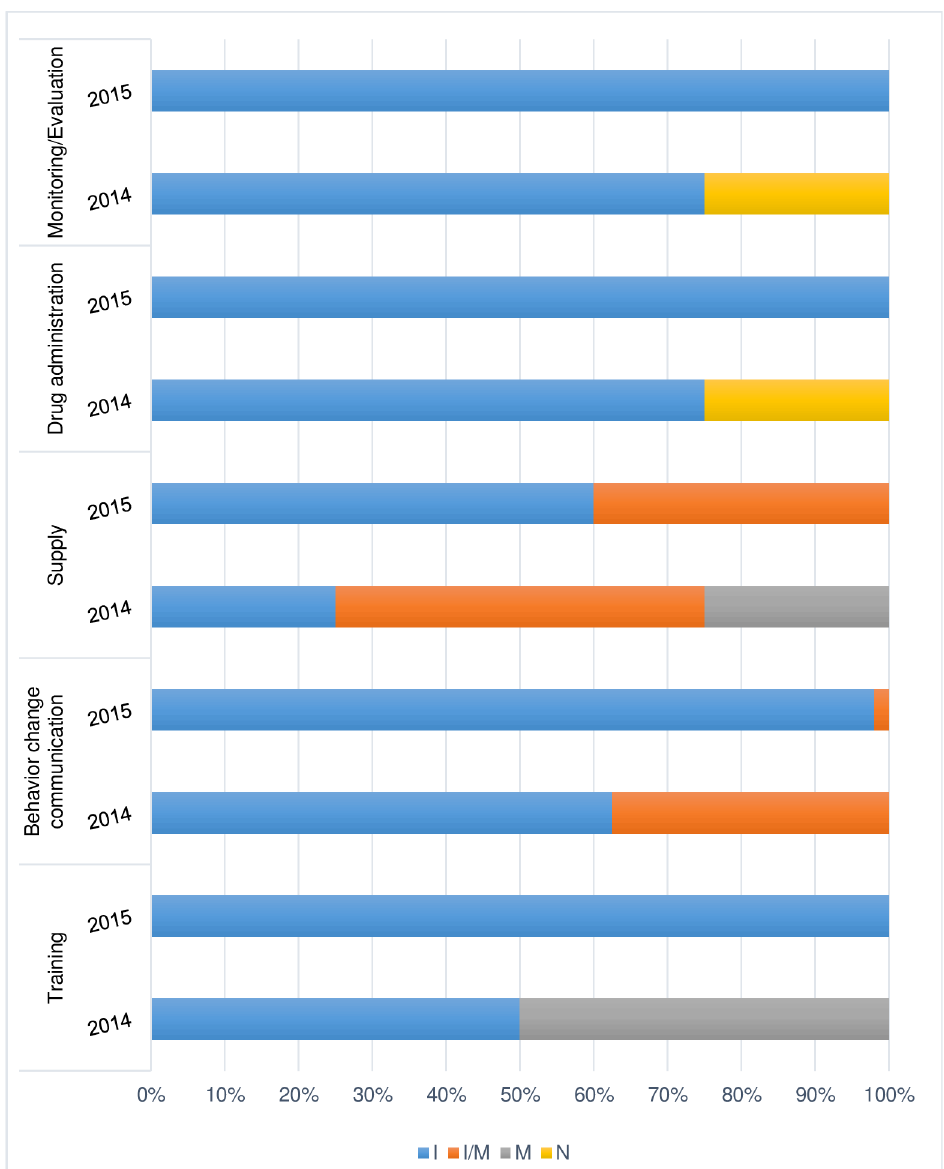
Fig 3. Fidelity of schedule of the SMC components in 2014 and 2015. Notes: I = implemented as intended; I/M = implemented or modified;M = modified;N = not implemented.